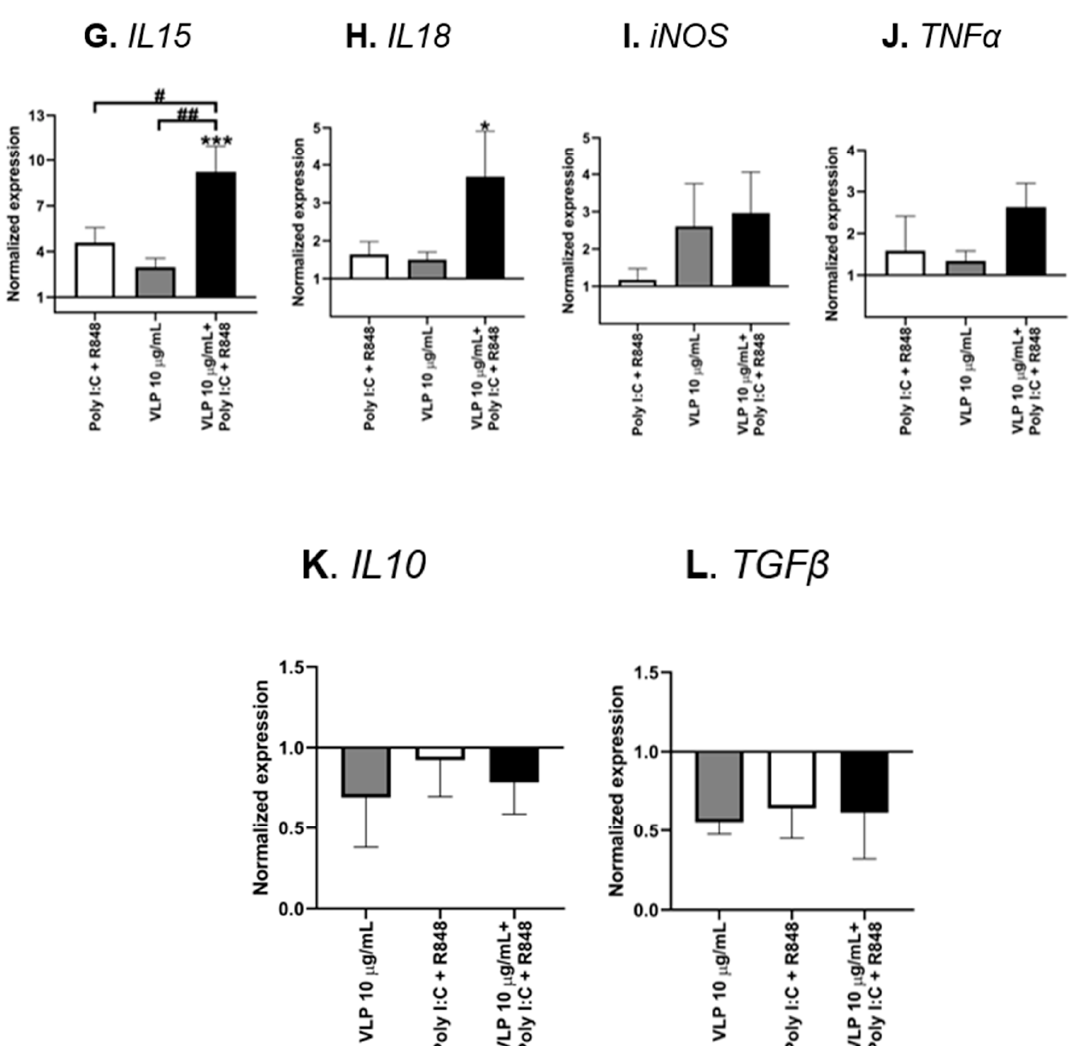
Figure 2. VLPs induce the expression of inflammatory genes in DCs. DCs were treated with 20 µ g/mL Poly I:C and 2.5 µ g/mL R848, or 10 µ g/mL VLPs, or VLPs plus 20 µ g/mL Poly I:C and 2.5 µ g/mL for 24 h. The expression of ( A ) CCL22 , ( B ) CCR7 , ( C ) IL1 β , ( D ) IL6 , ( E ) IL12A , ( F ) IL12B , ( G ) IL15 , ( H ) IL18 , ( I ) iNOS , ( J ) TNF α , ( K ) IL10 , and ( L ) TGF β genes was assessed using qRT-PCR, as described in Materials and Methods. Each column expresses the normalized expression to the control (not stimulated cells) and represents the mean ± SEM of at least three experiments. * p < 0.05; ** p < 0.01; *** p < 0.001 relative to the control; # p < 0.05; ## p < 0.01 among the other comparisons. VLP: virus-like particles, Poly I:C: polyinosinic:polycytidylic acid, R848: